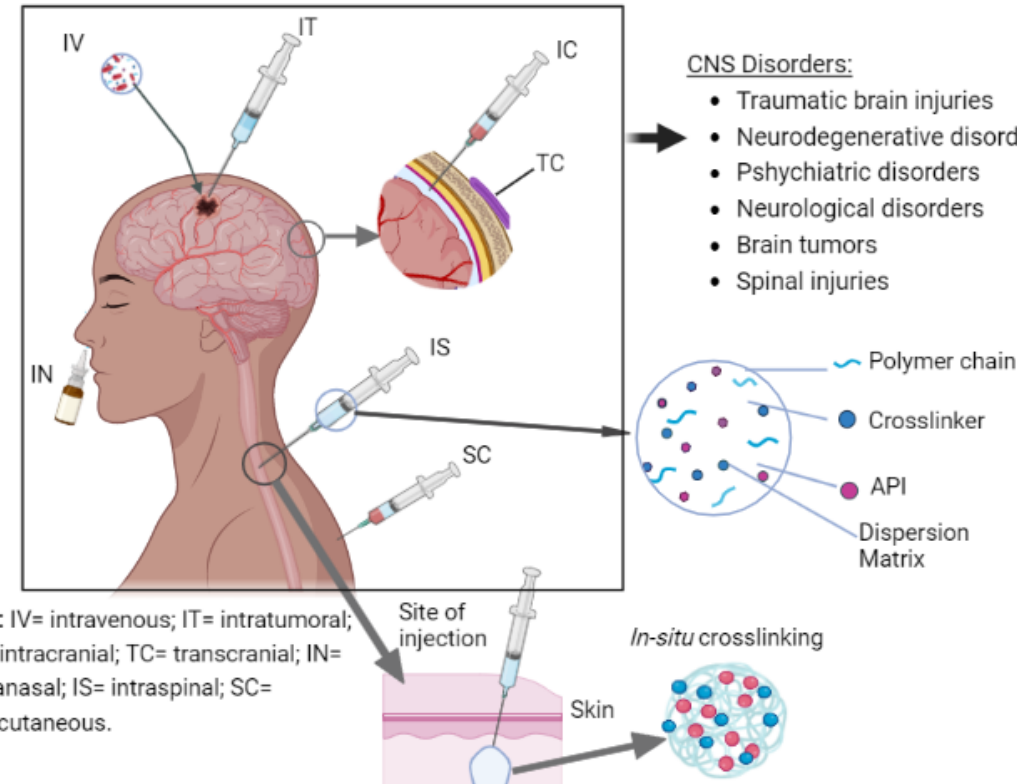
Figure 10. Pictorial illustration of the in-situ gel formation following the administration of drug loaded cross-linked gel for CNS conditions. Key: IN = Intranasal injection; IC = Intracranial; SC = Subcutaneous Injection, IV = Intravenous and IS = Intraspinal.